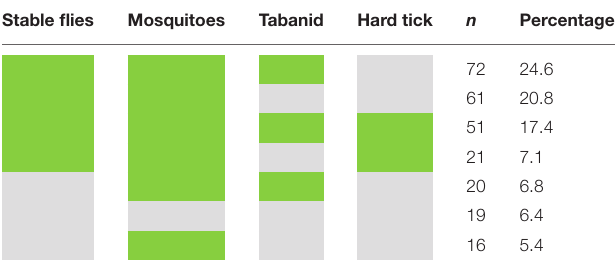
TABLE 2 | Primary pattern of insects found in lumpy skin disease outbreak farms. Stable flies Mosquitoes Tabanid Hard tick